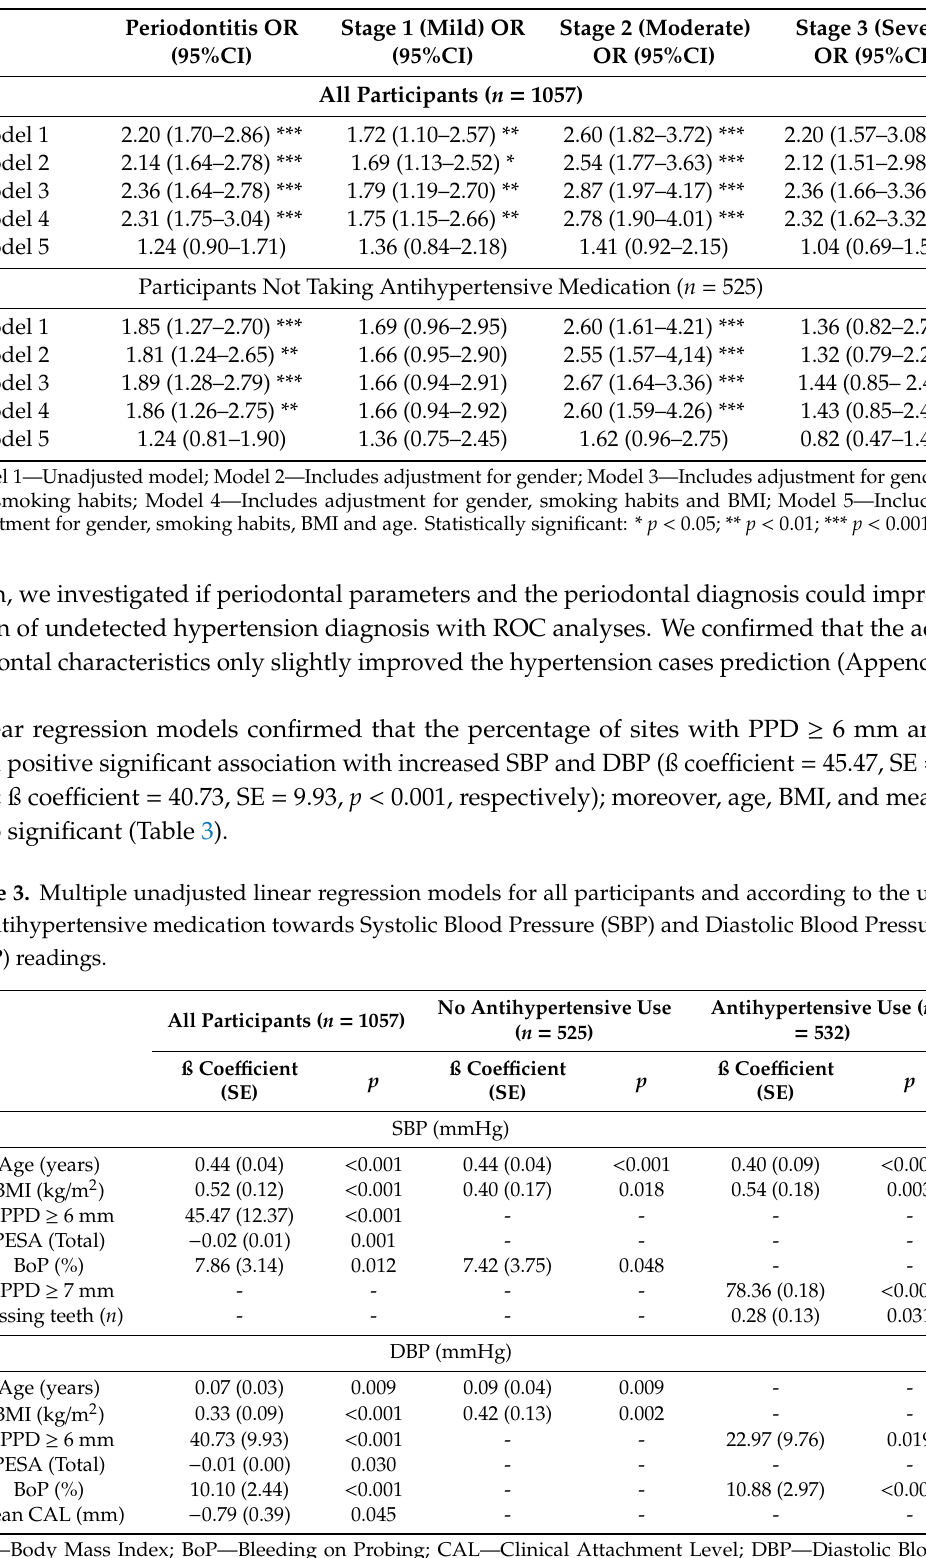
Table 2. Odds ratios (OR) and correspondent 95% confidence intervals (CI) towards hypertension, according to the periodontal status, calculated within binary logistic regression analyses for di ff erent adjustment levels.